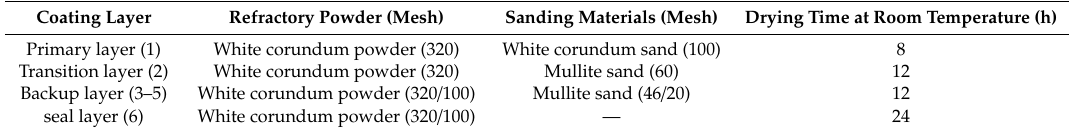
Table 2. Materials and process for the preparation of shell samples.